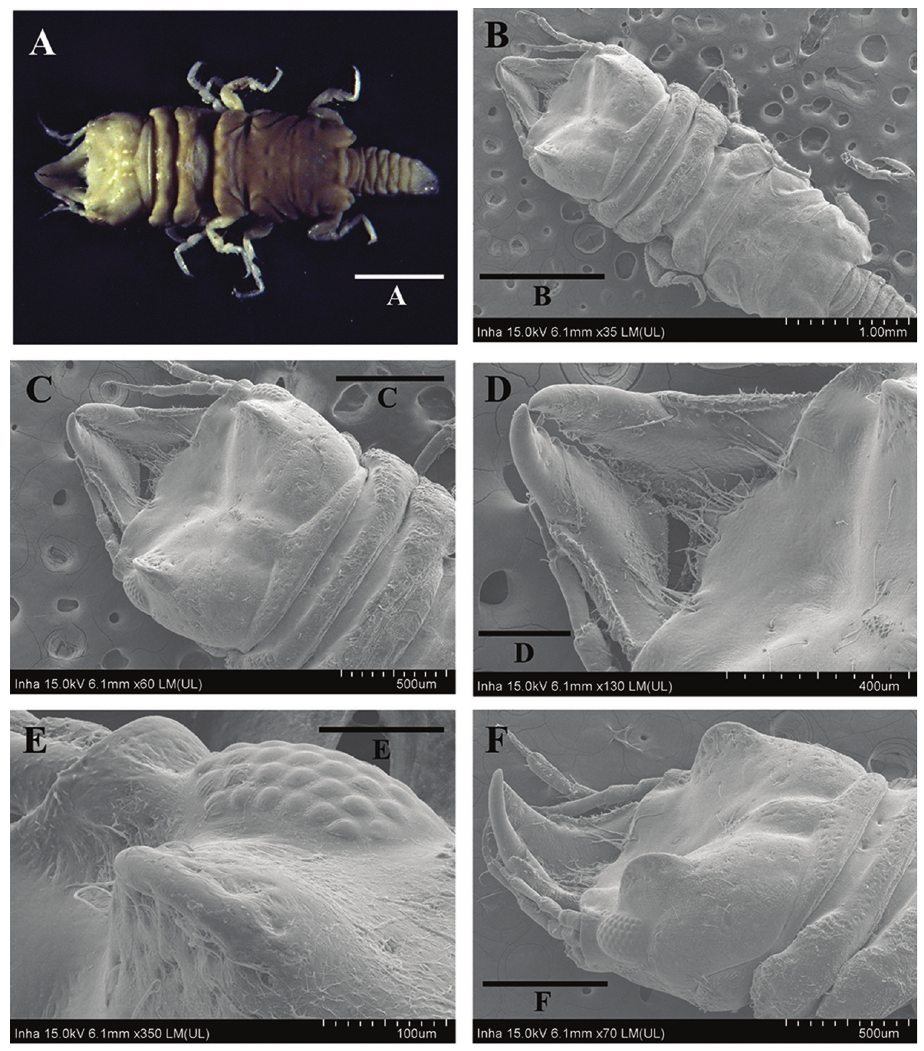
Figure 1. Gnathia koreana sp. n., male holotype A body, dorsal view B body, dorsal view C cephalon D mandible E paraocular ornamentation, dorsal view F paraocular ornamentation, lateral view. Scale bars: 1 mm ( A, B ), 0.5 mm ( C, F ), 0.4 mm ( D ), 0.1 mm ( E ). weakly concave; mid-dorsal surface with two sub-median setae, posterolateral margins with two submarginal setae, apex with two setae. Antennula (Figure 2C) peduncle article 2 0.6 times as long as article 1; article 3 1.7 times as long as article 2; flagellum with five articles. Antenna (Figure 2D) peduncle article 4 3.0 times as long as wide, 1.2 times as long as article 3, with two penicillate setae; flagellum with seven